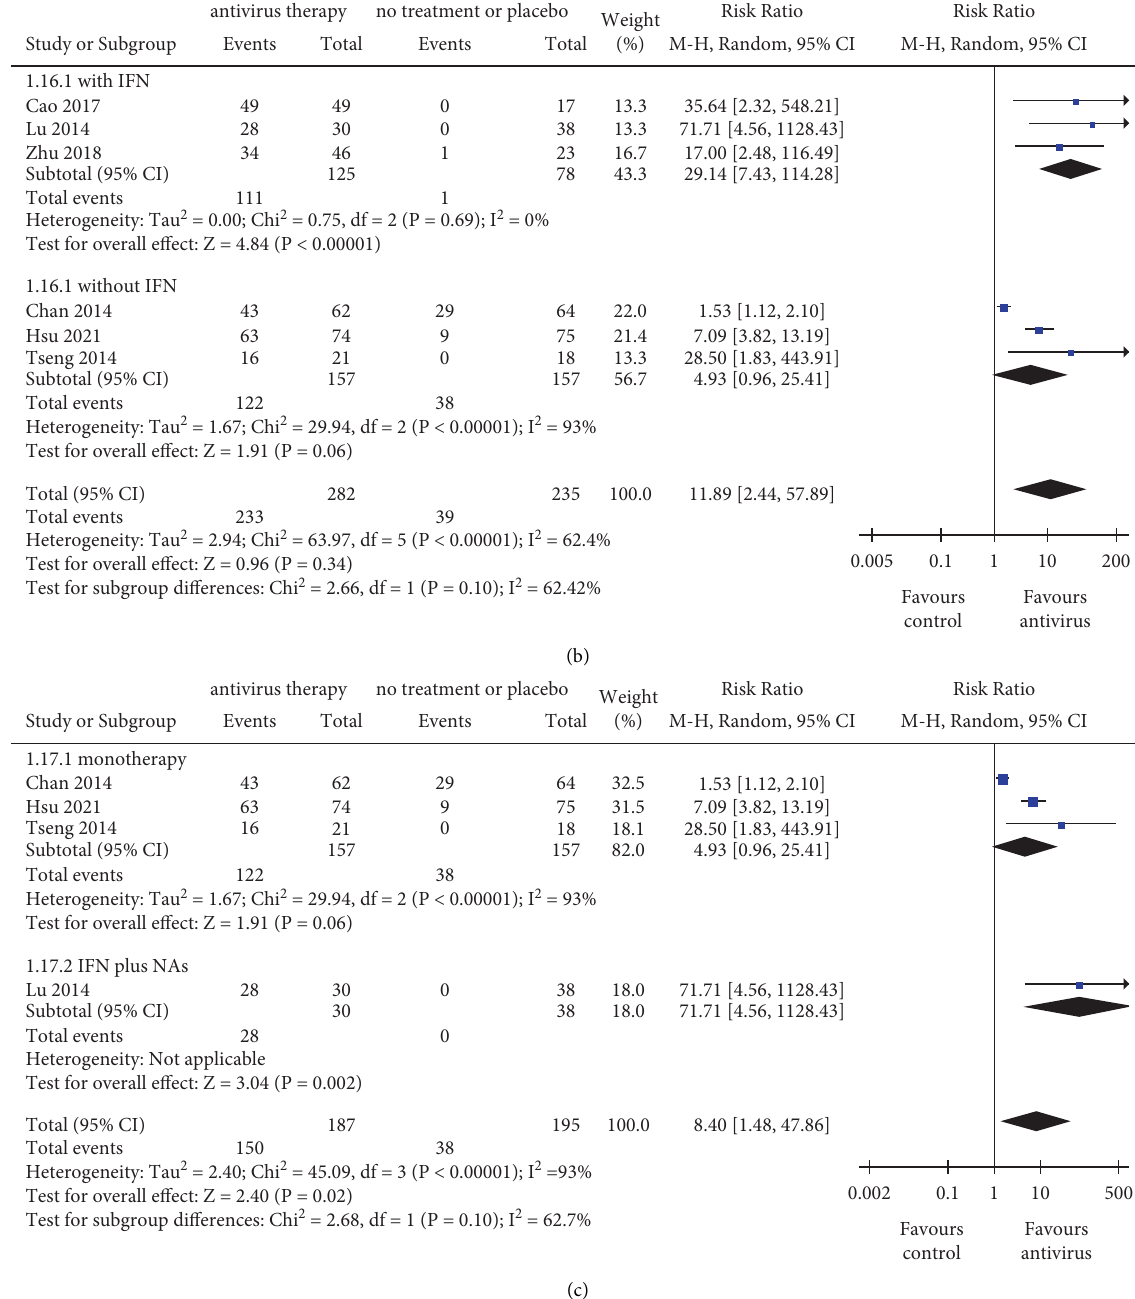
Figure 6: Te outcomes of undetectable HBV DNA. (a) Pooled risk ratio for undetectable HBV DNA between the antiviral therapy group and control group. (b) Subgroup analysis stratifed by therapeutic regimen with or without IFN. (c) Subgroup analysis stratifed by monotherapy and combined therapy (IFN plus NAs). NAs, nucleos(t)ide analogs; IFN, interferon; CI, confdence interval; monotherapy group exclusively included NAs or IFN. Te size of square represents the weight of each study, and the vertical dotted line represents the pooled